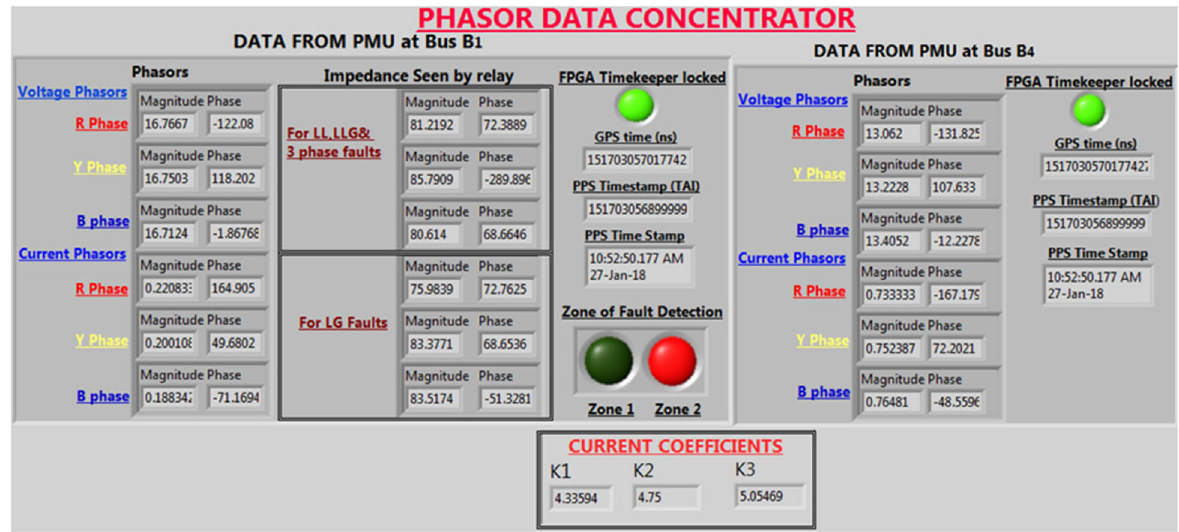
Fig. 15 LabVIEW front panel display of PDC at SPC showing the performance of distance relay R A with the proposed PAZSD methodology for an LLG fault (FR = 4.9 Ω ) at 350 km from B